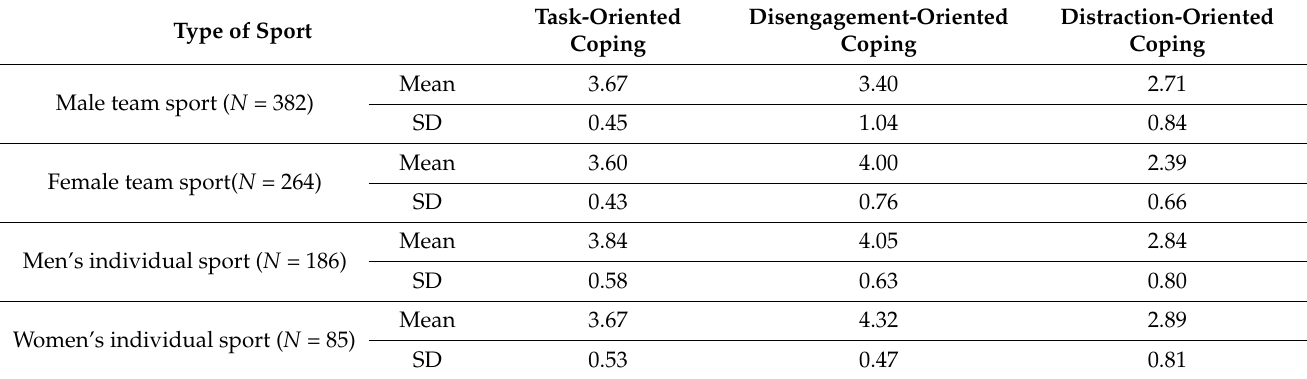
Table 6. Second-order coping scores compared to the type of sport.